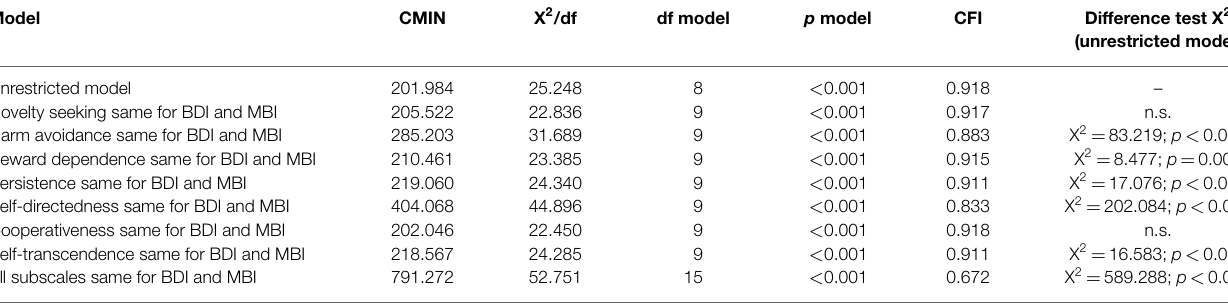
TABLE 4 | Results of the path analyses comparing MBI sum score and BDI 2 for the employee sample .